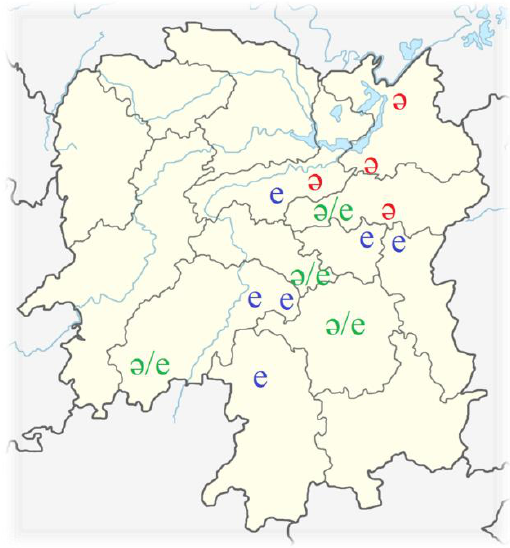
Figure 3. Contrastive open syllable mid-vowels by dialect.